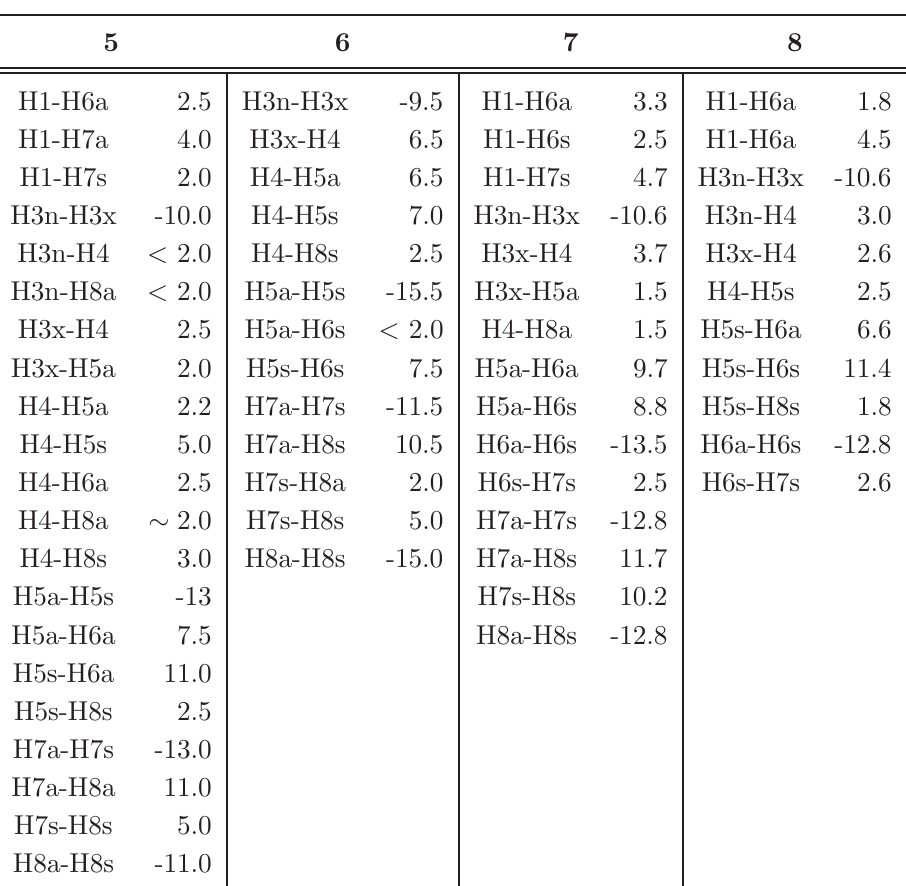
Table 6 Coupling constants ( J , Hz) deduced from the first order analysis of the 1 H NMR spectra of compounds 5-8